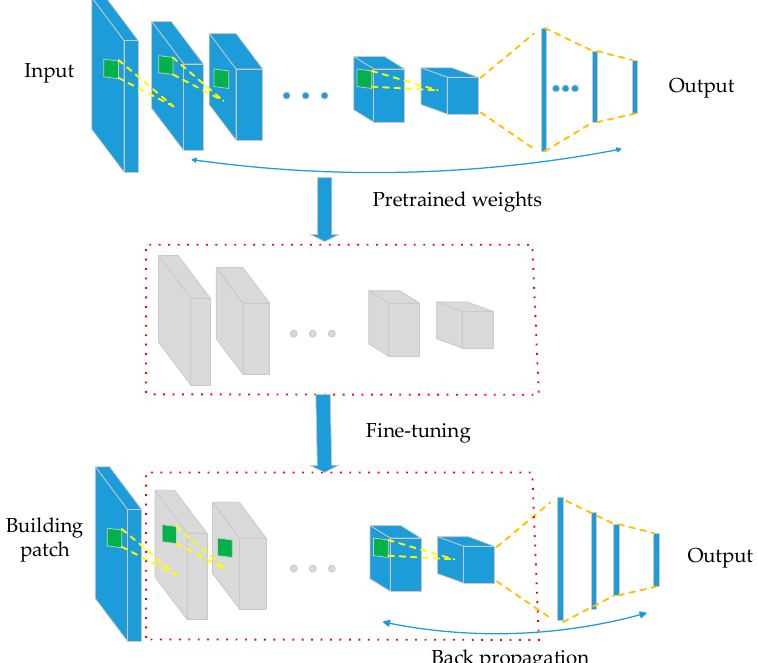
Figure 3. Illustration of fine-tuning pretrained Visual Geometry Group (VGG)Net for discriminating collapsed buildings after an earthquake.